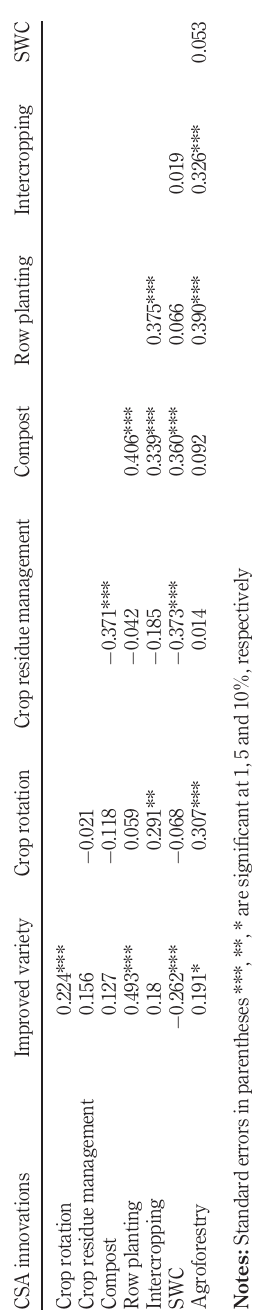
Table 4. CSA innovations adoption